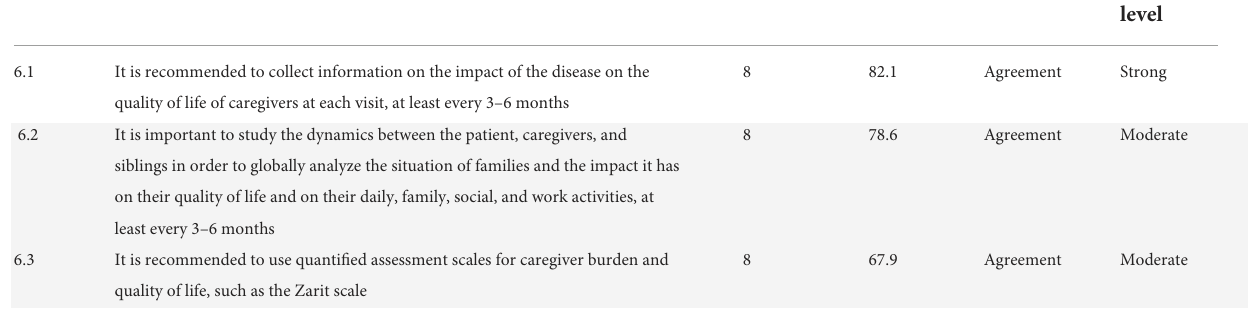
TABLE 6 Assessment of the quality of life of